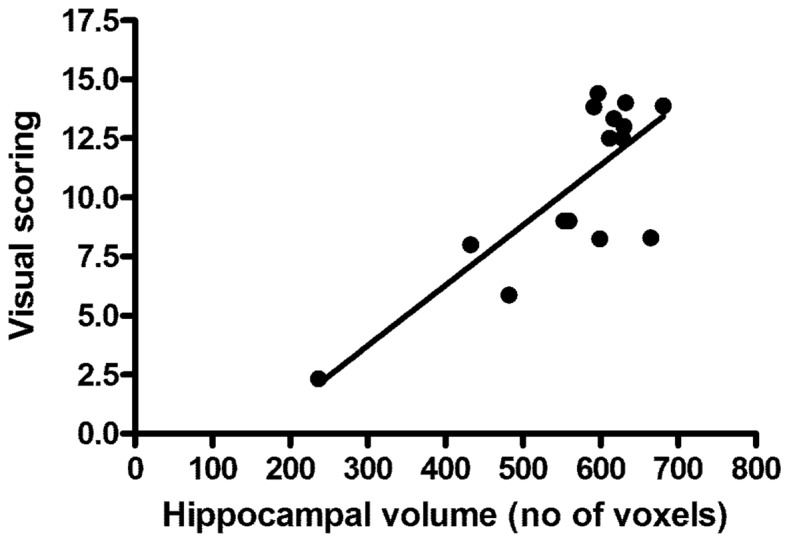
Relationship between whole hippocampal volume and cell loss in the left hippocampus.Spearman's correlations of whole hippocampal volume against summed visual scoring of cell loss in the left hippocampus. A significant correlation was observed (p<0.05, r2 = 0.60).